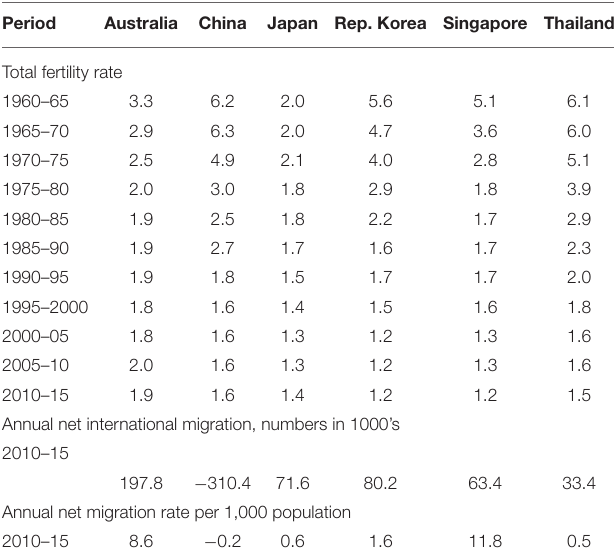
TABLE 2 | Total fertility rates and annual net international migration, averages for 5-years periods, six countries.